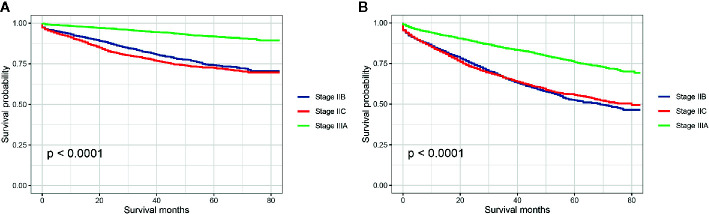

(A) Colon cancer-specific survival and (B) overall survival for stage IIB, stage IIC, and stage IIA colon cancer patients.